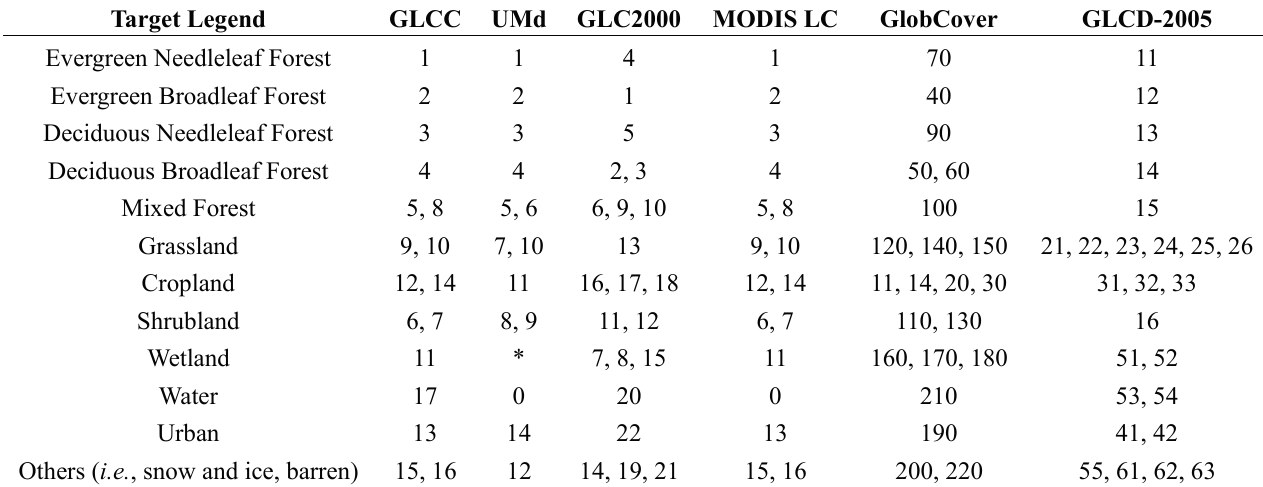
Table 4. Conversion table of map legends. Refer to Table 3 for the definition of each class number of original data sets.